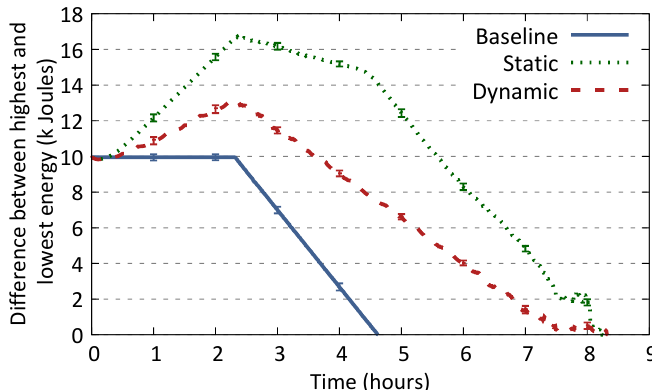
Figure 9. Difference between the highest and the lowest energy values in the